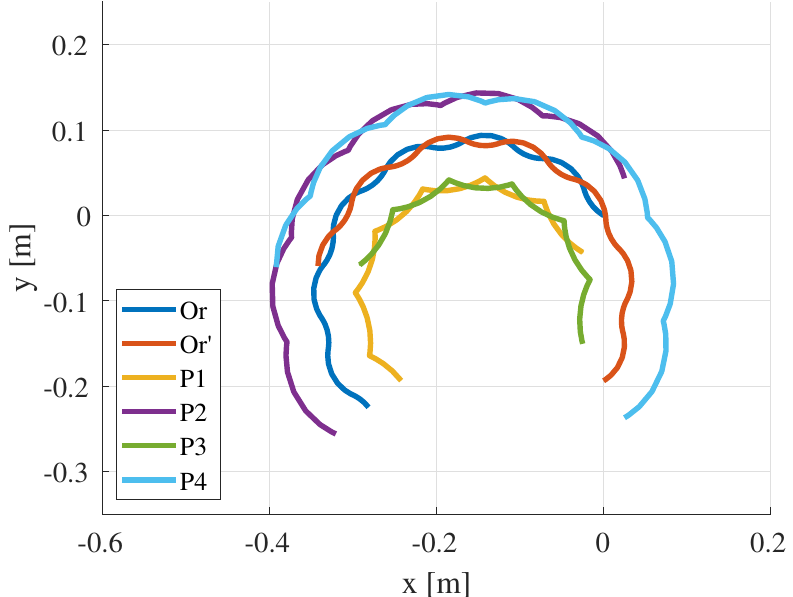
Figure 11. The trajectories of each joint in the simulation for counter-clockwise turning locomotion. The simulation results show that the robot turns to the left by setting β = π